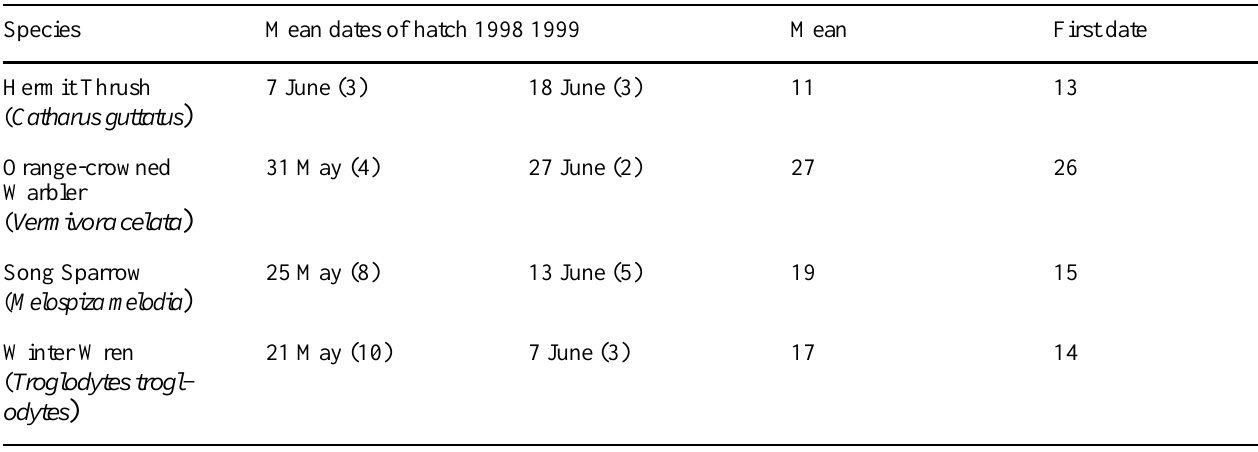
Table 3 . Information on hatching dates based on nests found with eggs. Sample sizes are given in